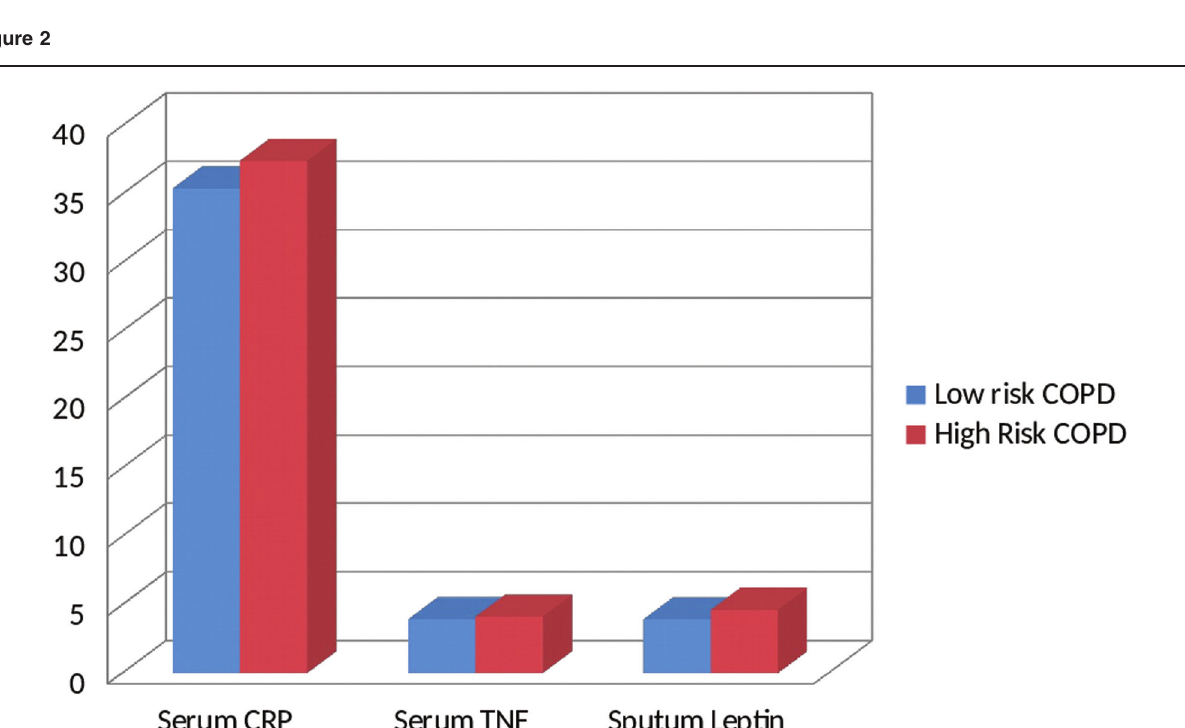
Correlation between serum CRP, TNF- α , sputum leptin in low- and high-risk patients. COPD, chronic obstructive pulmonary disease; CRP, C- reactive protein; TNF- α , tumor necrosis